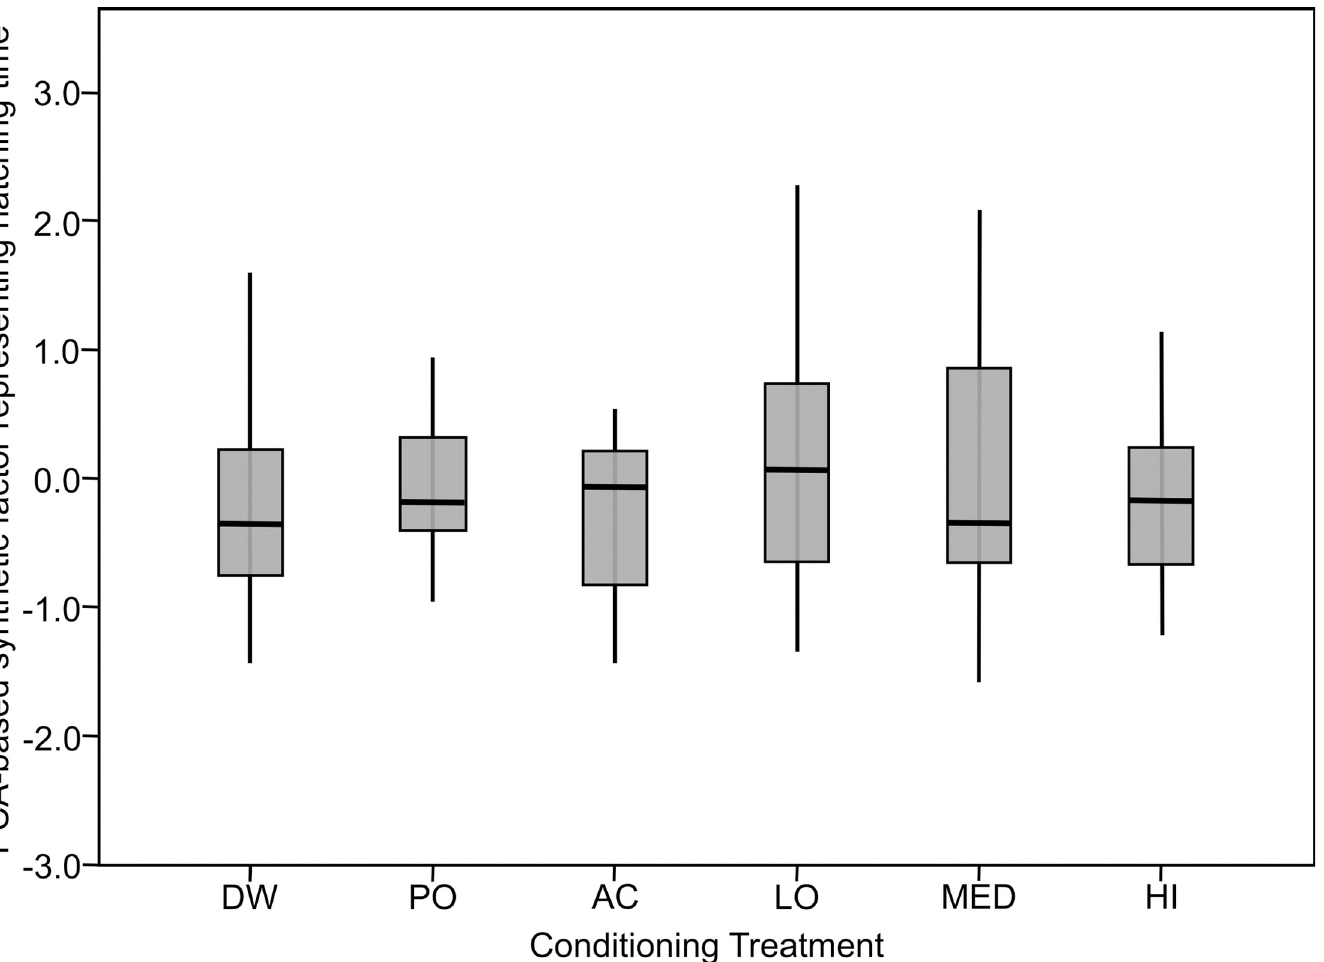
Fig 1. Variation in clutch hatching times following embryonic exposure to different treatment cues as represented by a PCA correlation-based synthetic factor that combines six measures of hatching time. DW = water, PO = predator odor, AC = alarm cue, LO = PO + low concentration AC, MED = PO + medium concentration AC, HI = PO + high concentration